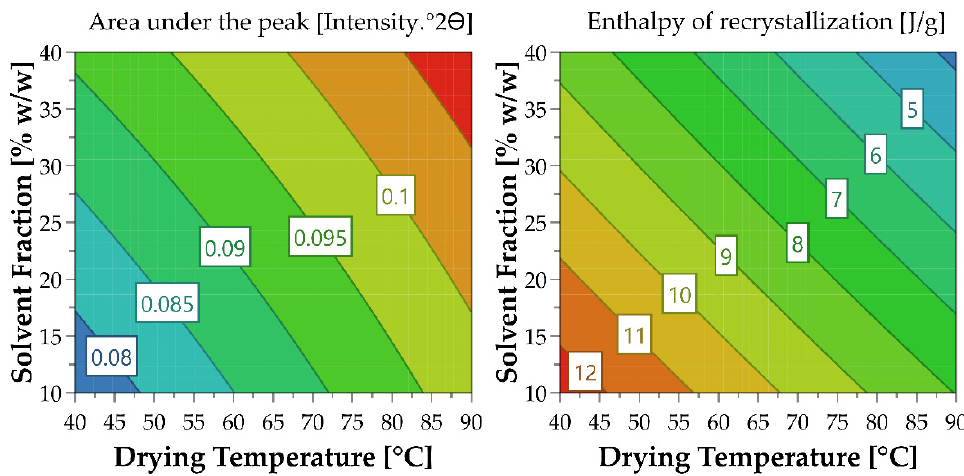
Figure 2. Effect of the drying temperature and solvent fraction (% w / w ) on the extent of OLZ recrys- tallization, as determined by X-ray powder diffraction (area under the peak of OLZ, 20.7–21.2 ◦ 2 θ ) and differential scanning calorimetry (enthalpy of